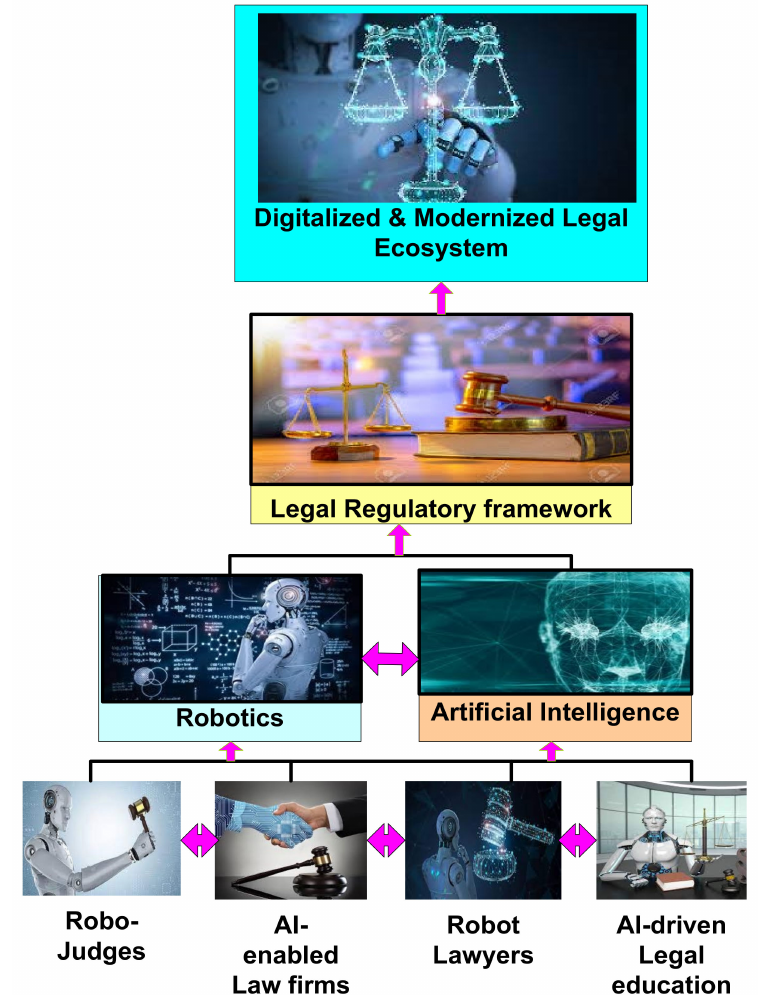
Figure 5. Digitized & modernized legal